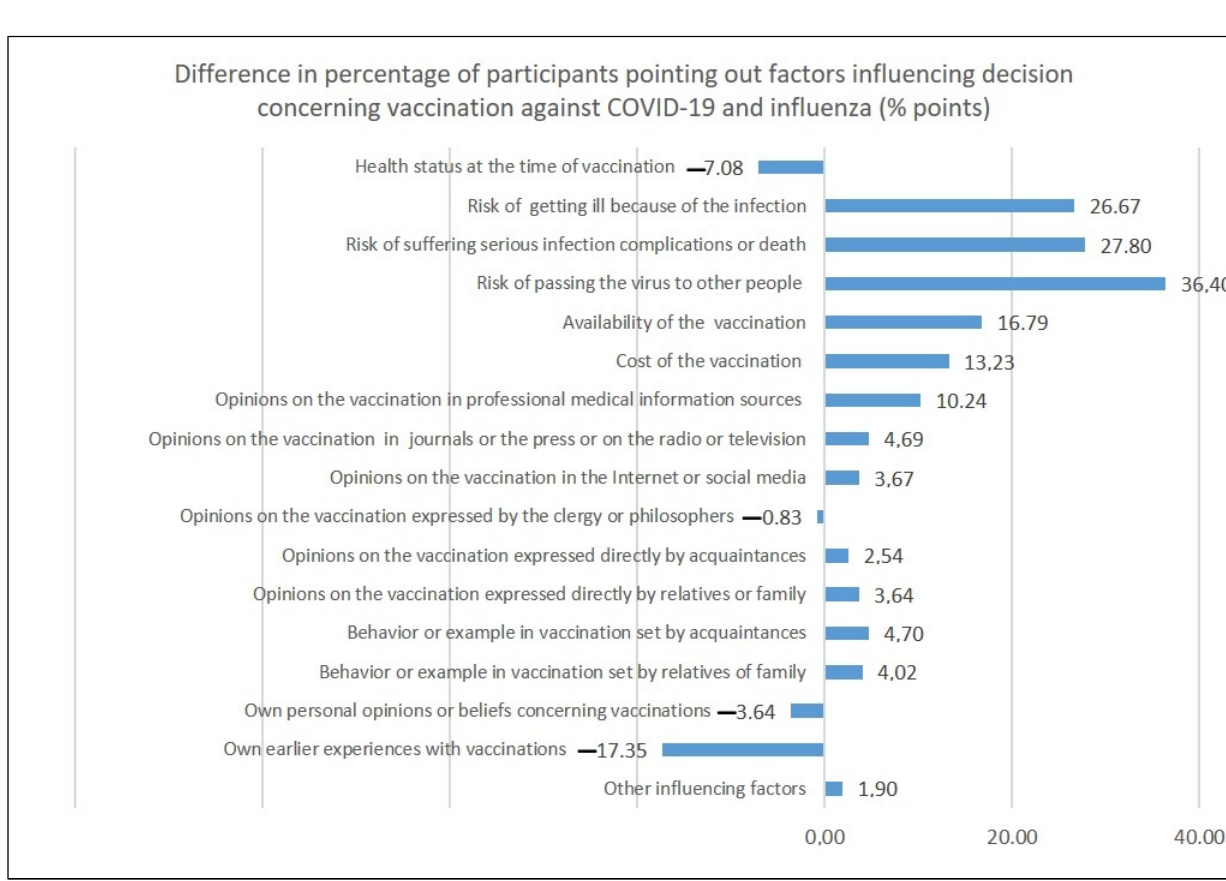
Figure 5. Differences in the percentage of participants pointing out factors influencing their decision concerning vaccination against COVID-19 and influenza (% points).